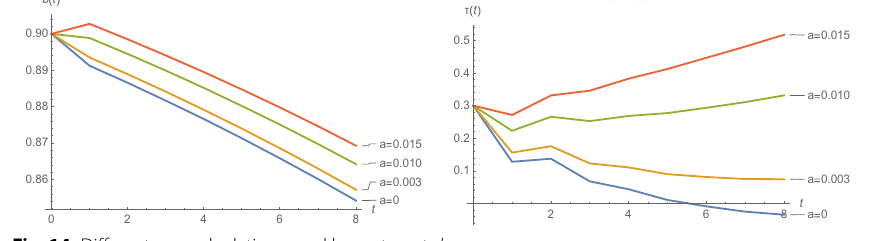
Fig. 14 Different second relation a and lower target d